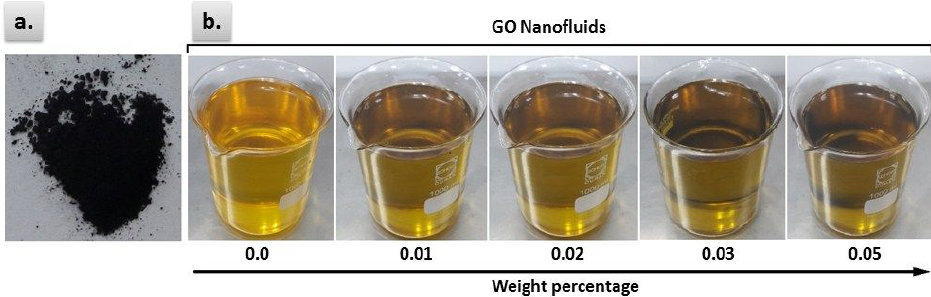
Figure 1. Visual images of the graphene oxide (GO) powder ( a ) and the prepared nanofluids ( b ).